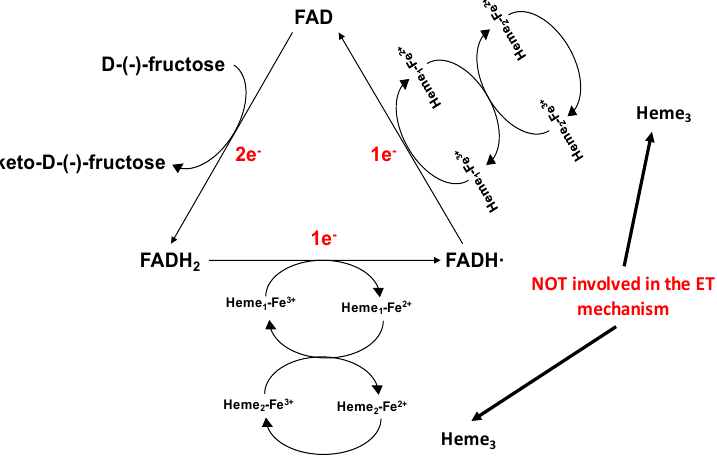
Figure 4. Suggested electron transfer mechanism for fructose dehydrogenase (FDH) at the electrode surface. D-(-)-fructose is oxidised to 5-keto-D-(-)-fructose releasing 2 electrons, which are transferred one by one through FAD first, followed by two heme c working as monoelectronic acceptors. Figure 4 is reproduced from [139] published as open-access paper in Analytical and Bioanalytical Chemistry edited by Springer-Verlag .